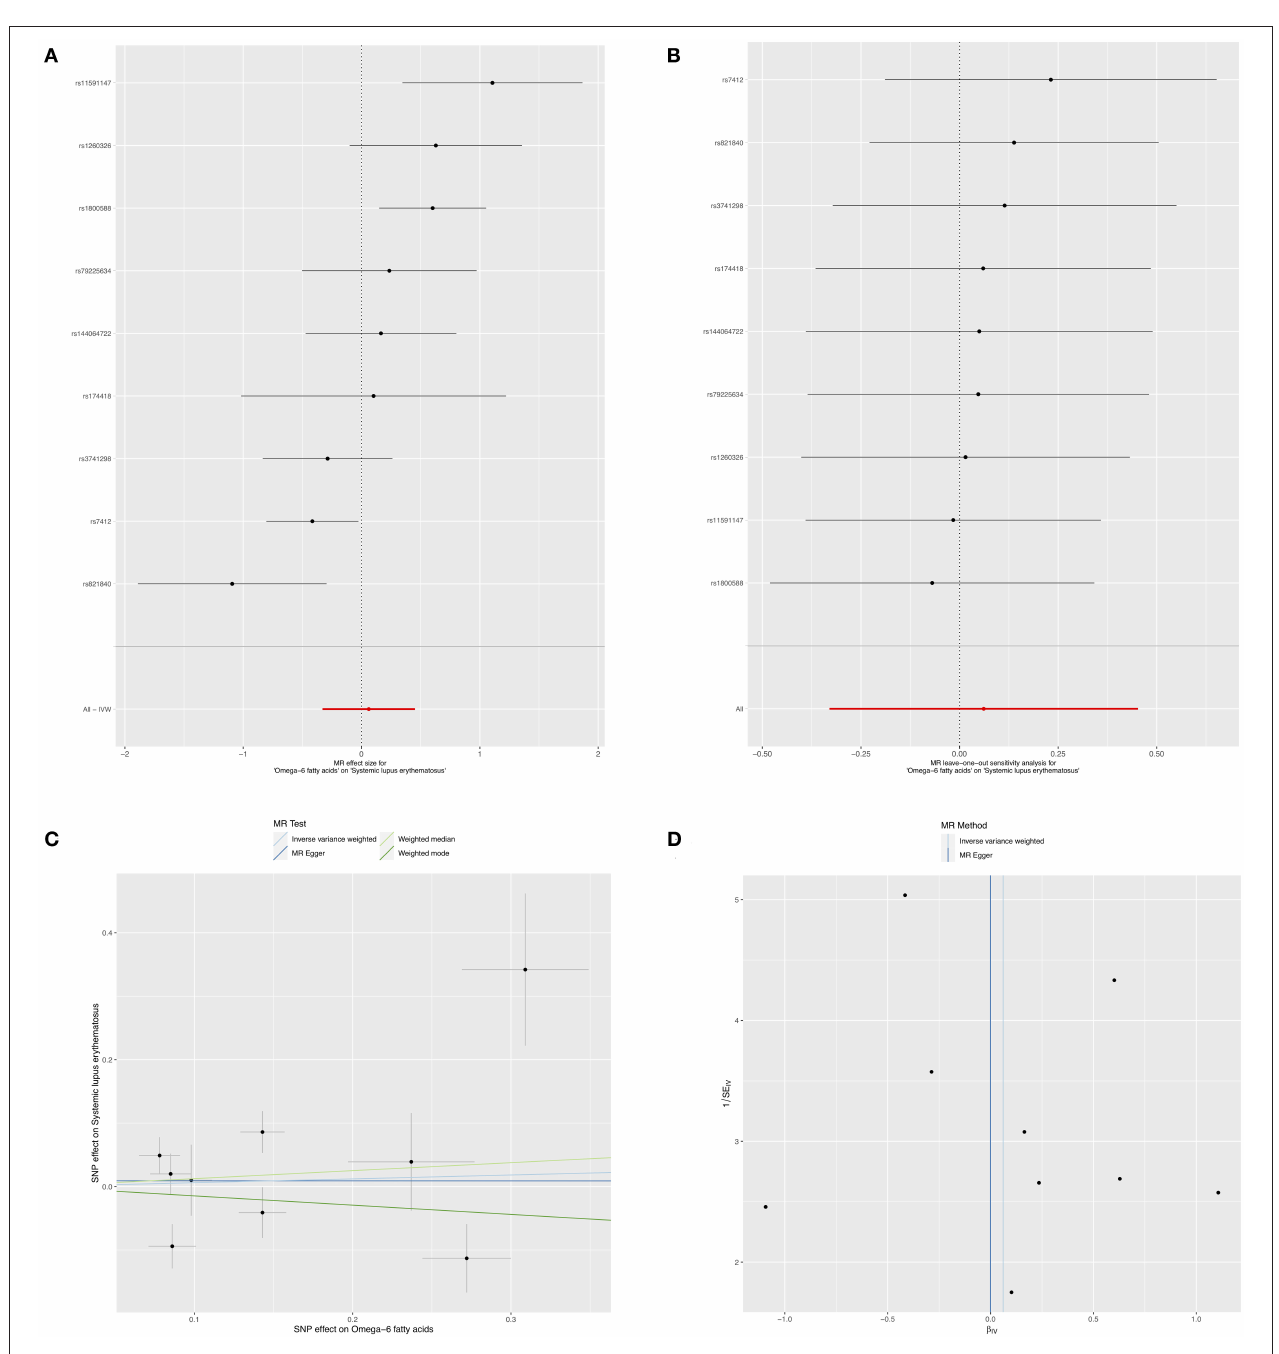
FIGURE 3 | Mendelian randomization study of the effects of omega-6 levels on SLE. Forest plot (A) , leave-one-out sensitivity analysis (B) , scatter plot (C) , and funnel plot (D) of the effect of circulating omega-6 levels on SLE.